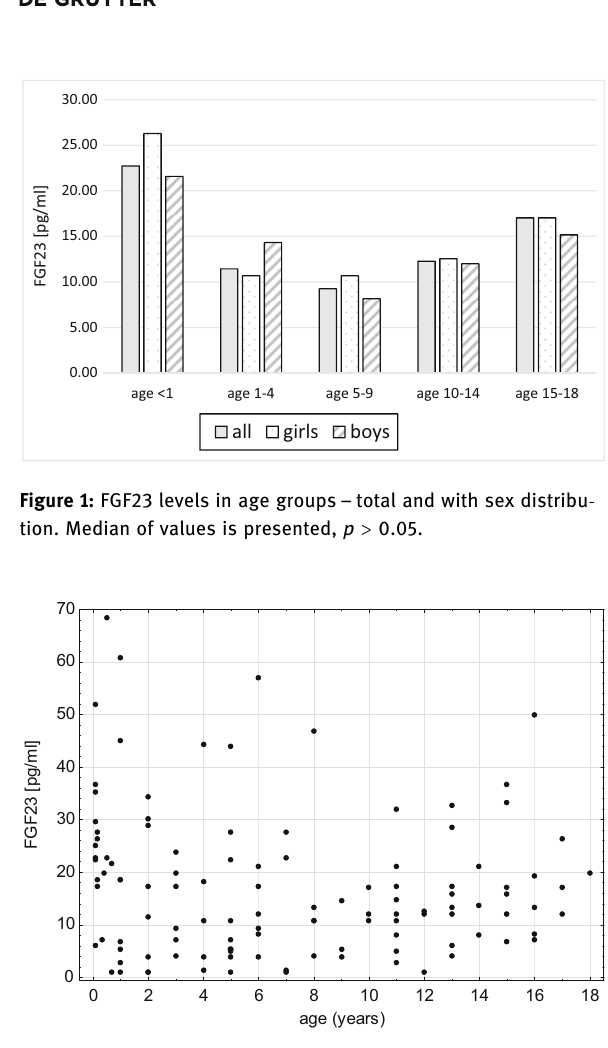
Figure 2: Scatter plot of serum FGF23 depending of the